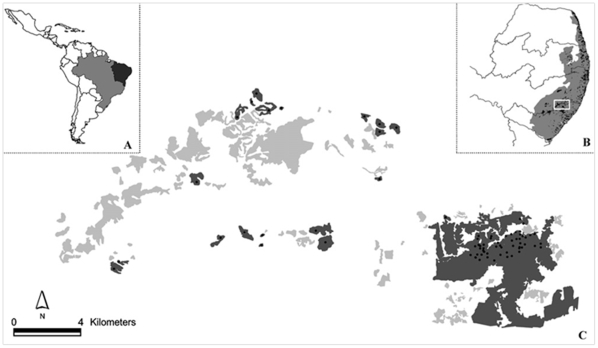
Study landscape at the Brazilian Atlantic forest.(A) Northeastern Brazil, where this study was conducted. (B) Distribution of the Atlantic forest of northeast Brazil ( =  Pernambuco Center of Endemism), note original (grey) and current (black) distribution of this forest in the region; white rectangle represents the study landscape (amplified in C). (C) Study landscape showing the location of 75 plots of 0.1 ha sampled to describe the phylogenetic diversity of tree assemblages in forest edges, small forest fragments, secondary forest patches and old-growth interior forests. Dark shaded polygons represent the forest fragments sampled; lightly shaded and white areas represent the remaining Atlantic forest remnants that were not sampled and a uniform matrix of sugarcane monoculture, respectively.